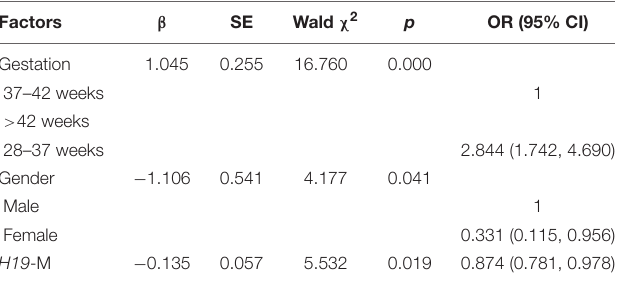
TABLE 7 | Logistic regression analysis of sperm DNA methylation and newborn BW.